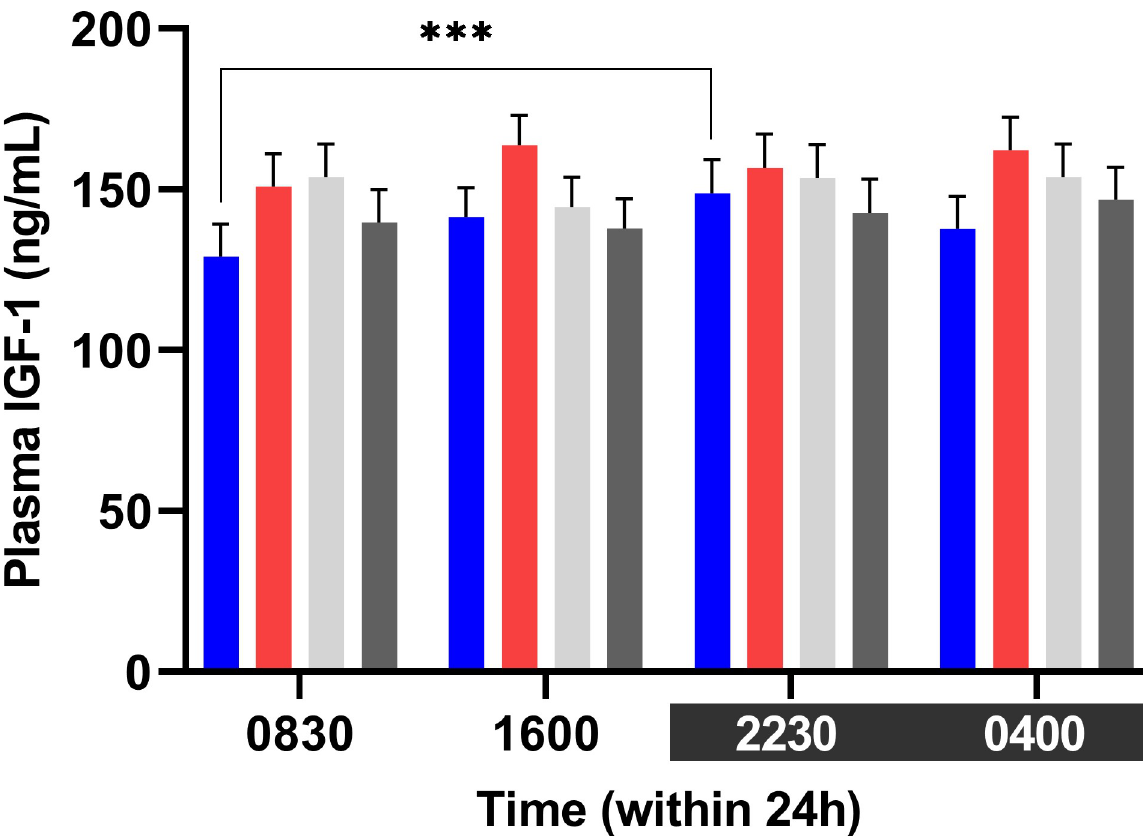
Fig 9. Treatment least squares mean (LSM) of plasma IGF-1 within 24 hours. Cows exposed to the Blue light treatment had higher plasma IGF-1 concentration at 2230 h than at 0830 h ( ��� p < 0.001).